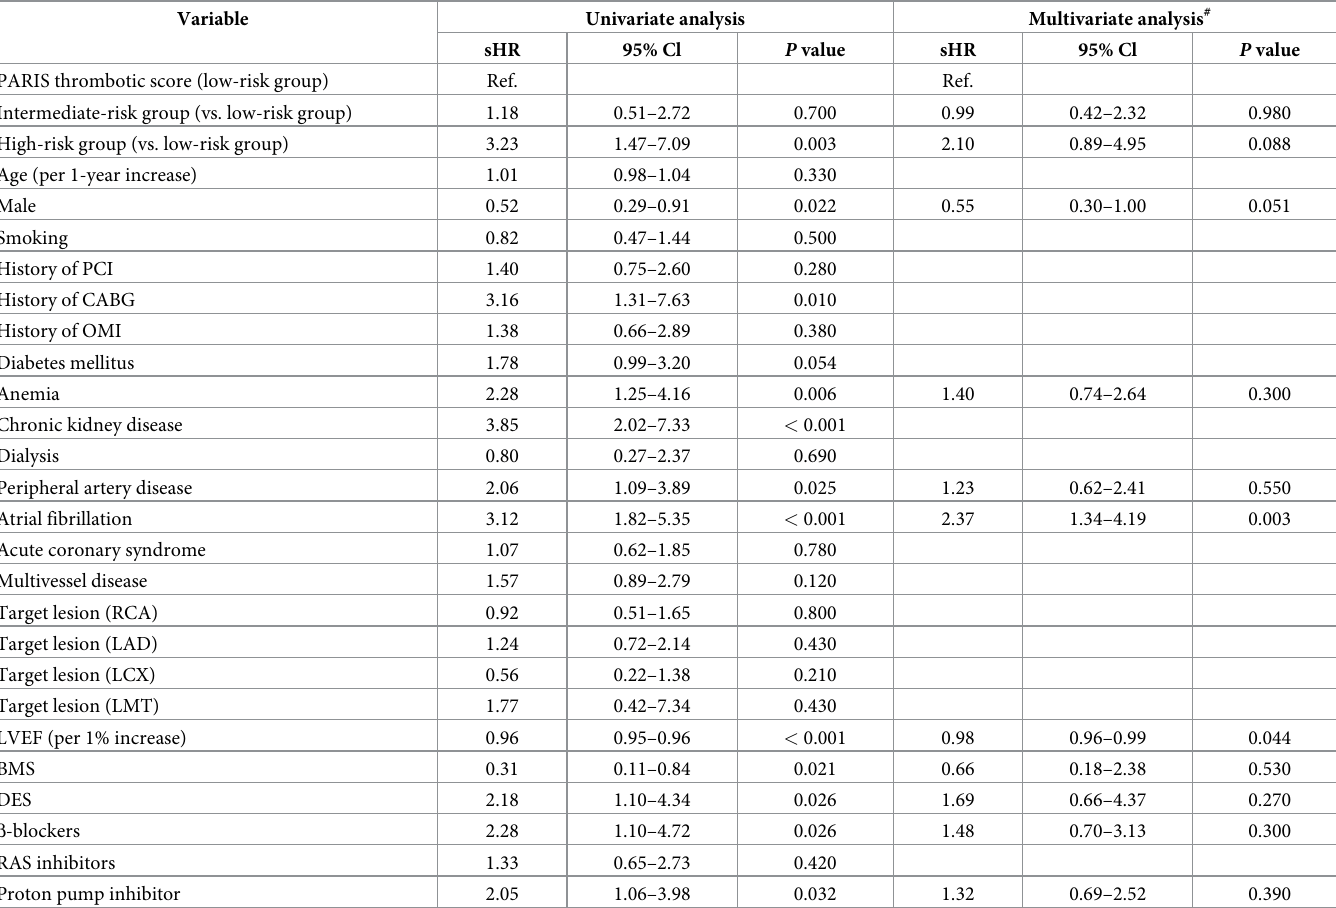
Table 7. Fine and Gray model (subdistribution hazard model) for hospitalization due to heart